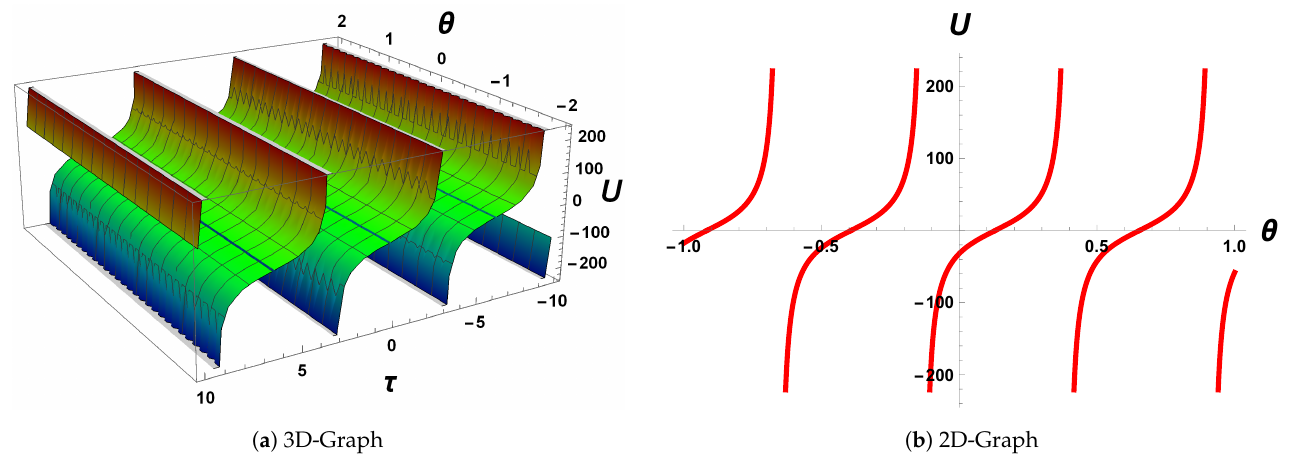
Figure 3. Diagrams a − 3 D and b − 2 D representation of U 4 ( θ , τ ) for l 1 = 1.5, l 2 = 0.75, δ = 2, γ 1 = 2, γ 2 = 0.5, and γ 3 = 1.7.